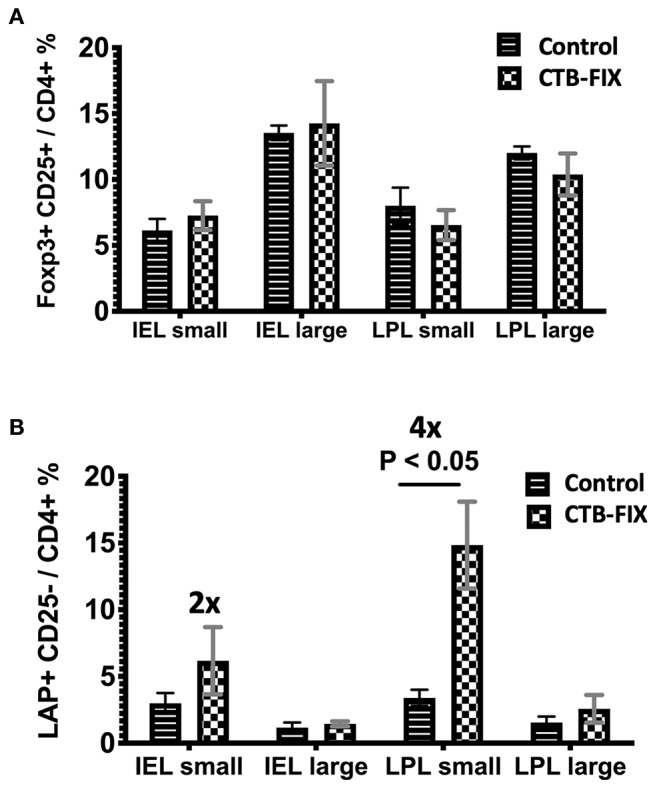
Frequencies of (A) CD4+CD25+FoxP3+ T cells and (B) CD4+CD25−LAP+ T cells among IEL and LPL populations of small and large intestines of orally tolerized and naïve control hemophilia B mice. Results are average ±SD (n = 5/group).